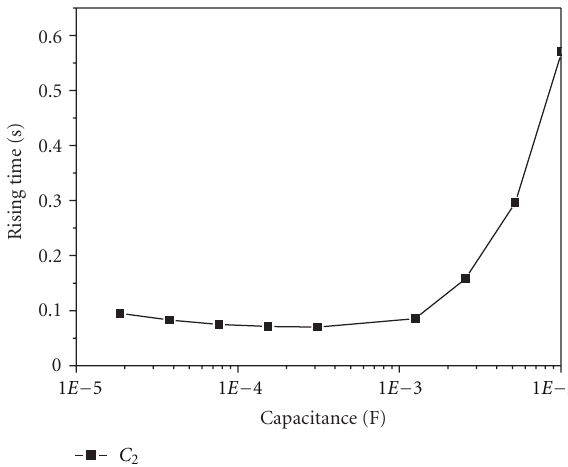
Figure 23: Response characteristic of the rising time for the pulse parameter for a change of the capacitance of C 2 (10 (nF) ∼ 10 (mF)).